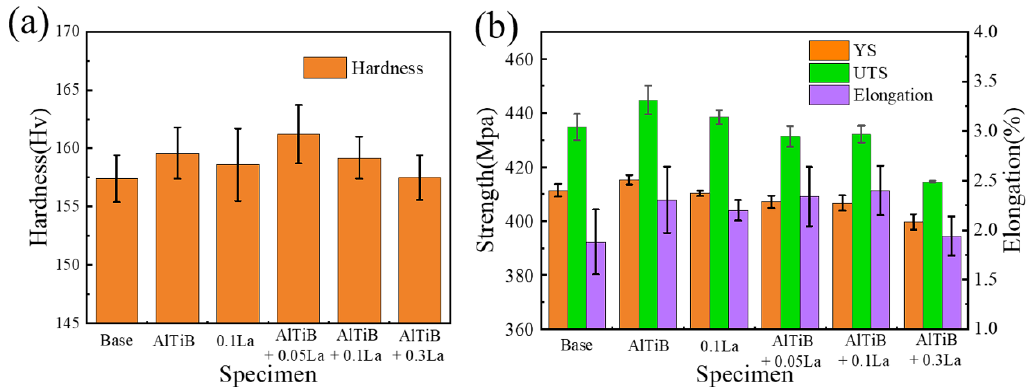
Figure 13. Mechanical properties after peak aging: ( a ) hardness test; ( b ) tensile properties.